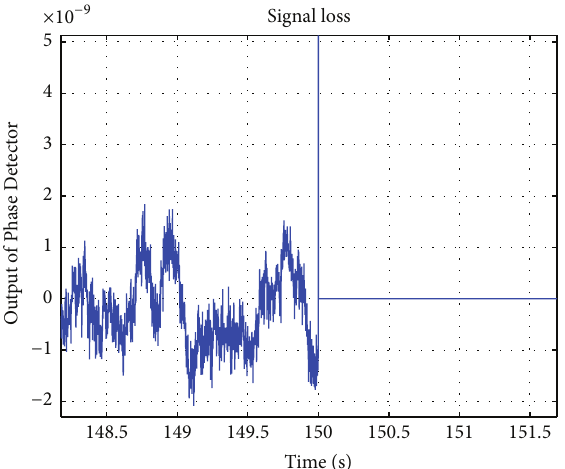
Figure 5: Response of Phase Detector to signal loss during simula- tion.